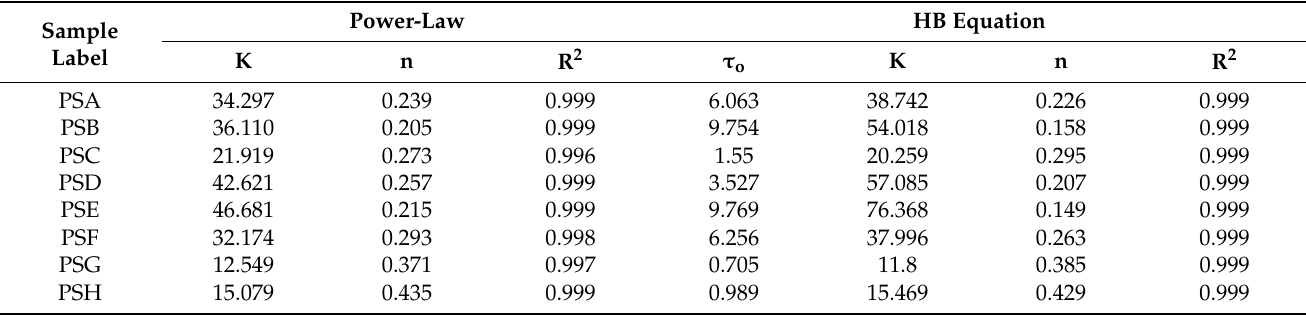
Table 1. Model parameters fitted with the Power-Law and HB models.